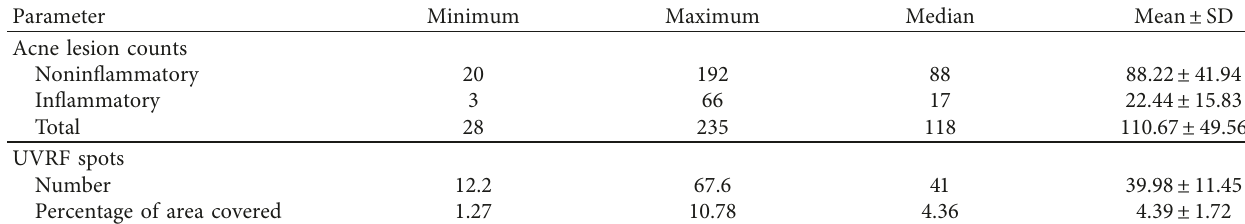
Table 2: Characteristic of acne vulgaris lesions and UVRF parameters.